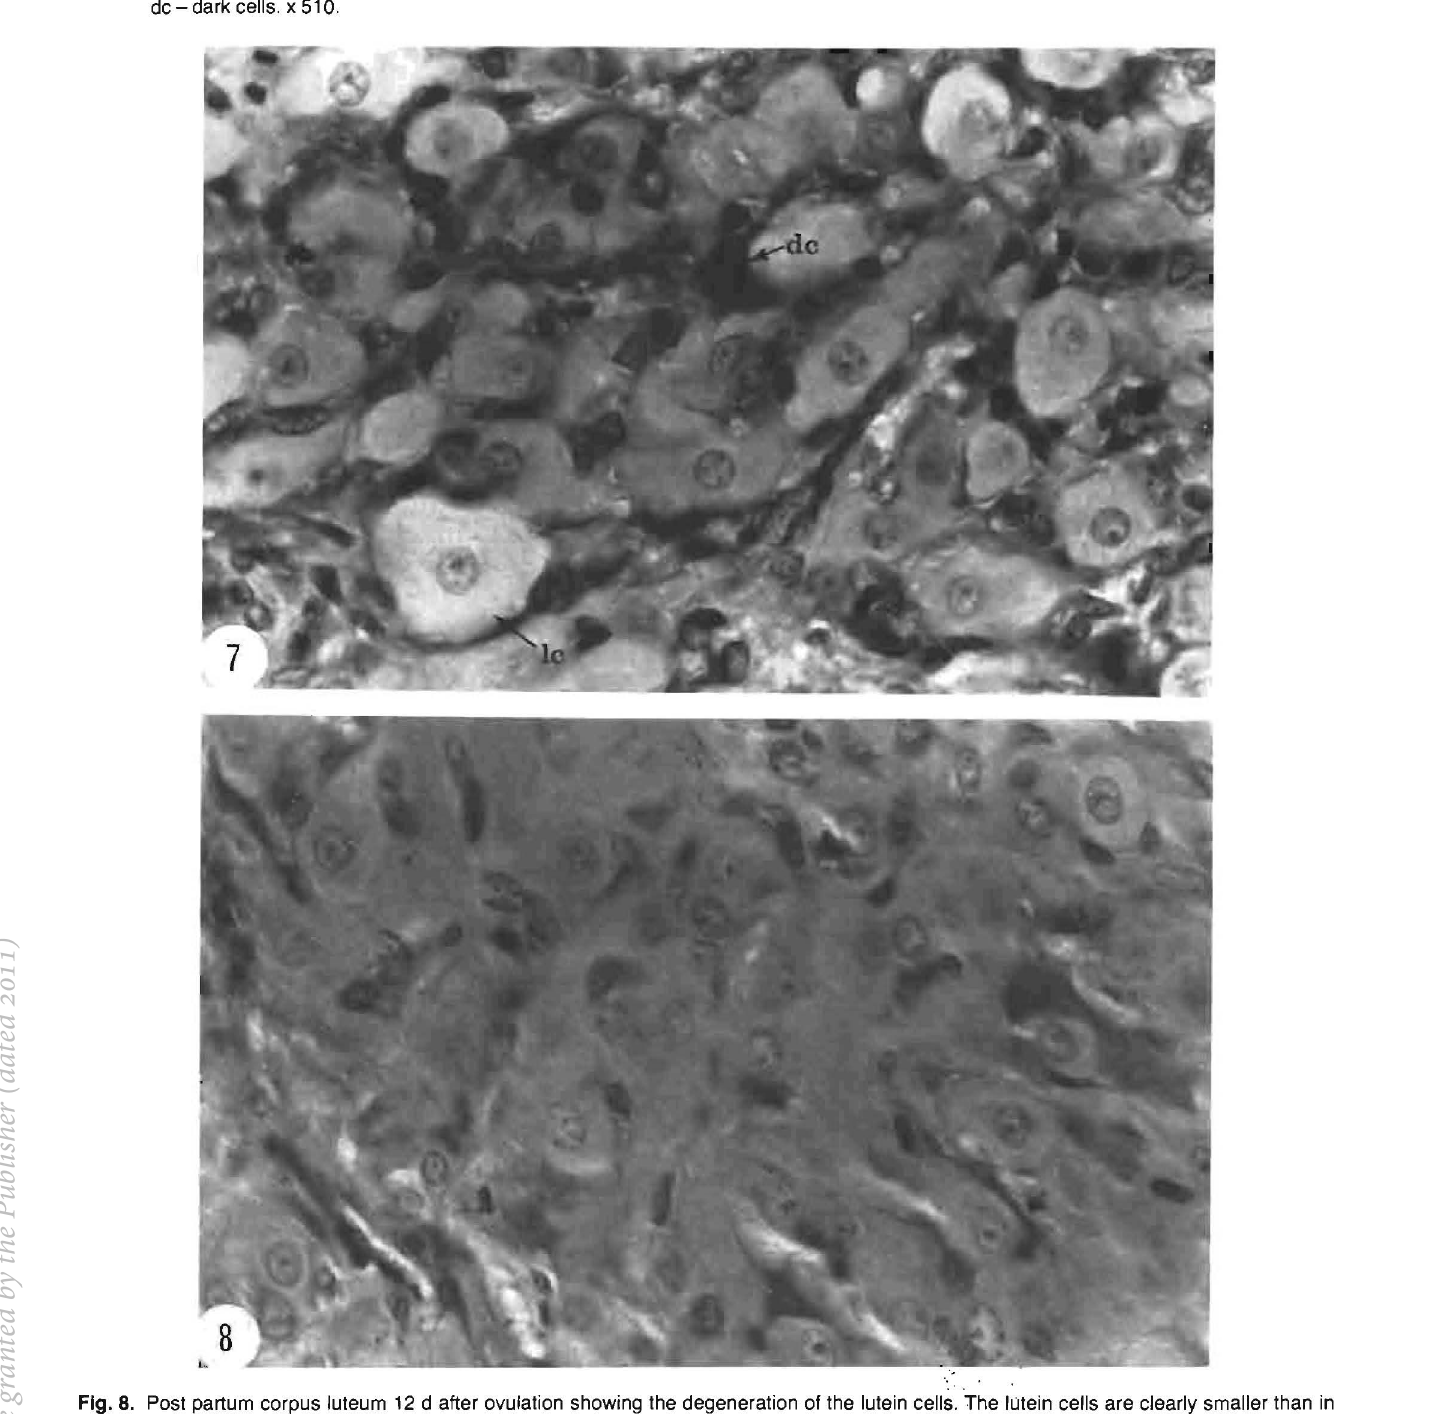
Fig. 8. Post partum corpus luteum 12 d after ovulation showing the degeneration of the lutein cells. The lutein cells are clearly smaller than in Fig. 7, and there seems to be an increase in the amount of stroma between them. x 510.